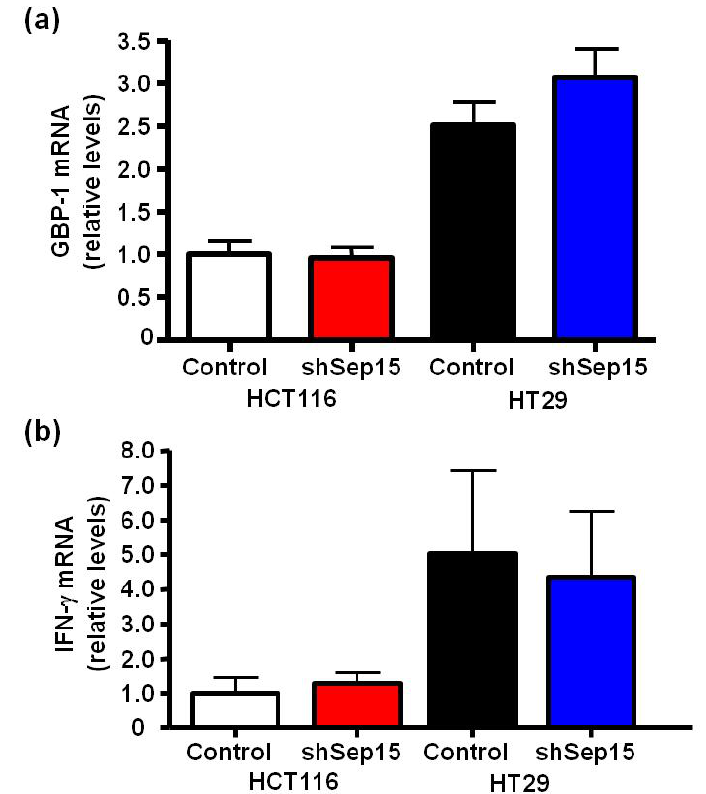
Figure 6. mRNA expression of guanylate binding protein-1 (GBP-1) and interferon- γ (IFN- γ ). mRNA levels of ( a ) GBP-1 and ( b ) IFN- γ in HCT116 and HT29 colon cancer cells were determined by quantitative real-time RT-PCR, with GAPDH used as internal control. Columns depict means ± SE ( t -test, n = 6), and were graphed relative to expression in HCT116 control cells (cycle threshold values were 17.6, 22.3 and 31.5 for GAPDH , GBP-1 and IFN- γ ,